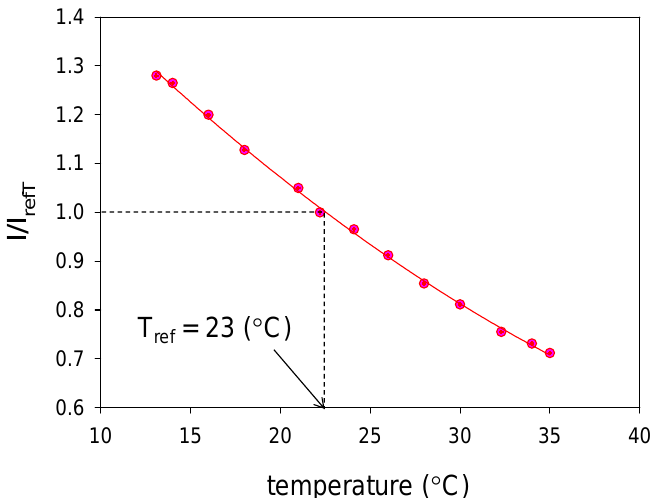
Figure 8. Temperature calibration result.